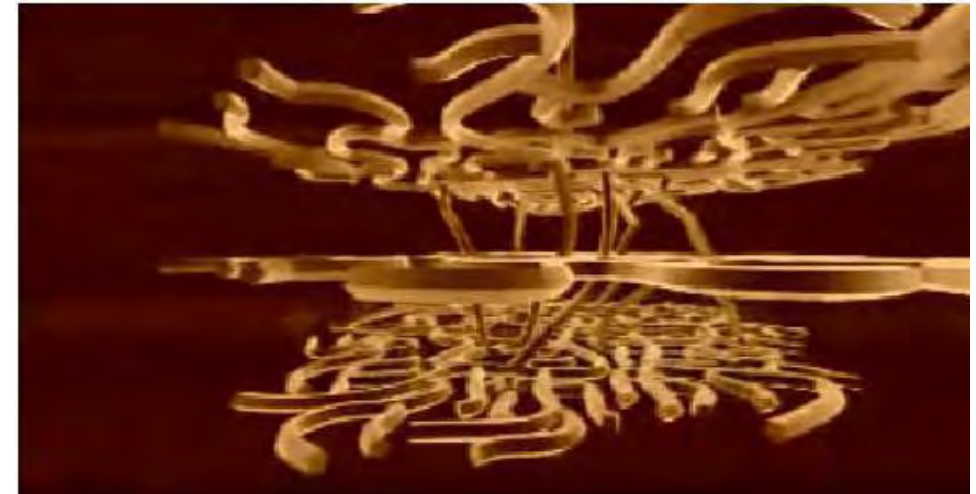
Figure 4 The underground passages’ model of ZhangBi